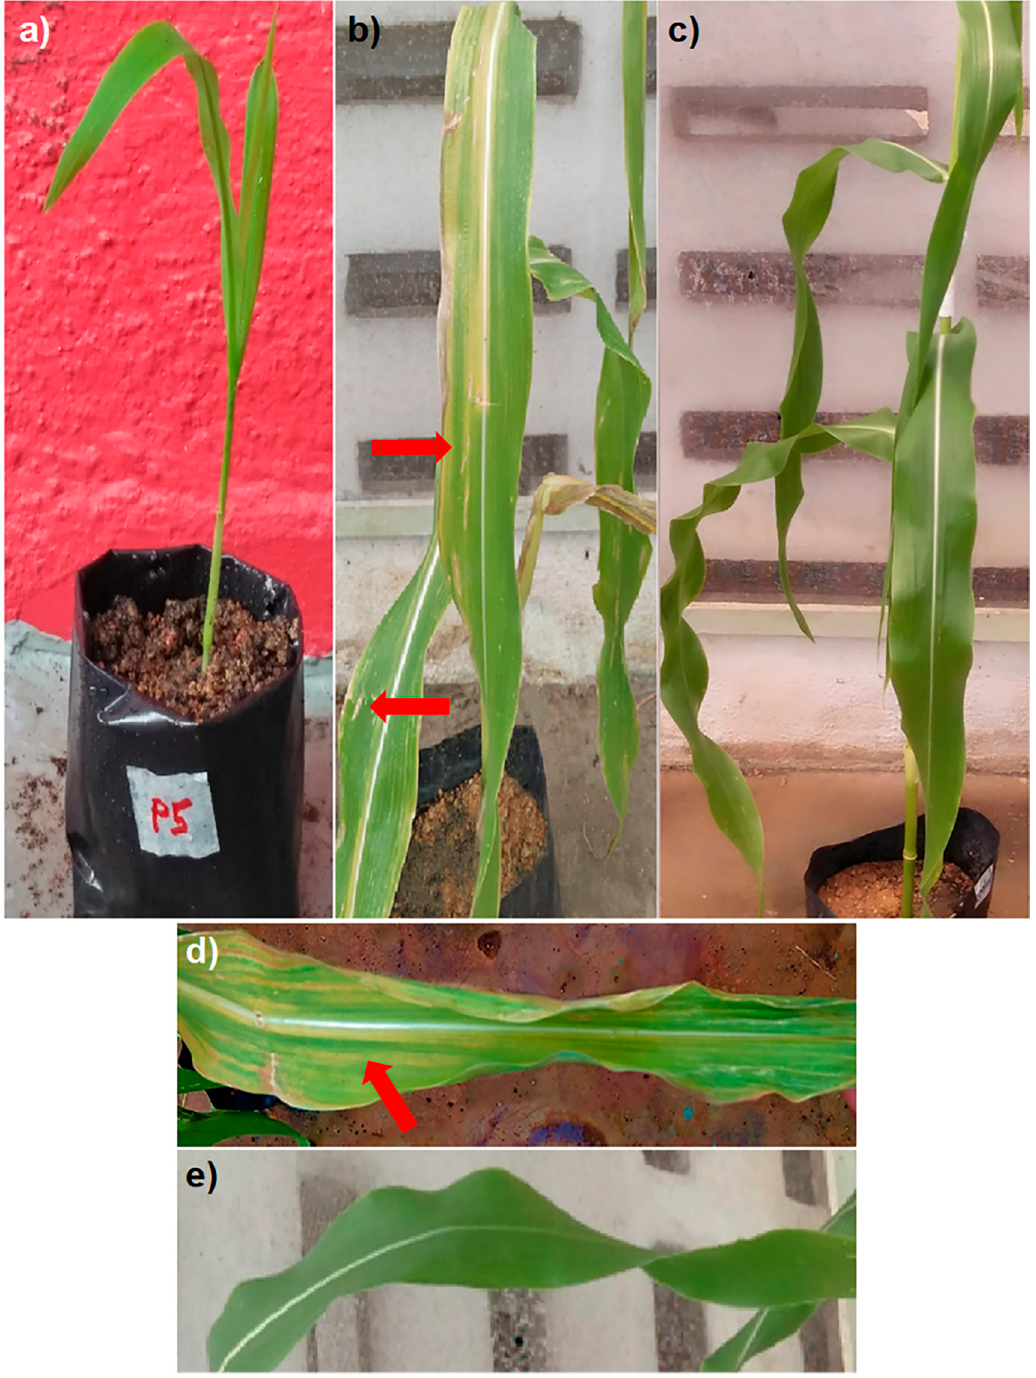
Figure 3. Inoculation of the Pantoea stewartii subspecies stewartii into sweetcorn, 14 days post-inoculation. ( a ) No symptoms on two-week-old seedlings inoculated with the isolate IPOH-5; ( b ) appearance of linear pale yellow streaks on nine-week-old seedlings inoculated with the isolate MAR-D; ( c ) control nine-week-old sweetcorn; ( d ) appearance of linear pale yellow streaks with wavy margins on isolate MS-C; ( e ) control sweetcorn.